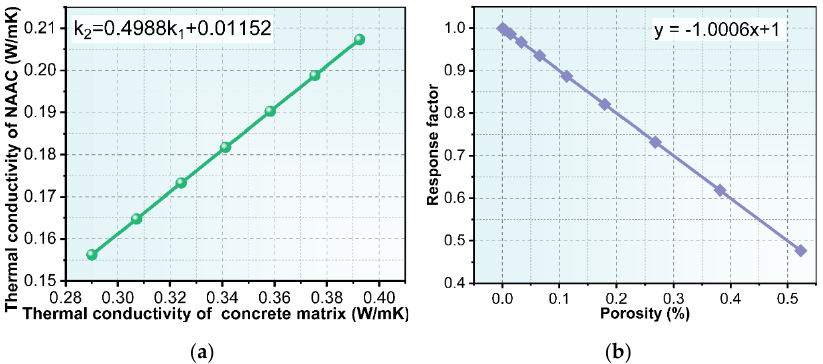
Figure 13. ( a ) Effect of concrete matrix thermal conductivity on the thermal conductivity of NAAC; ( b ) response coefficient of the NAAC thermal conductivity with different porosities to the concrete matrix’s thermal conductivity.